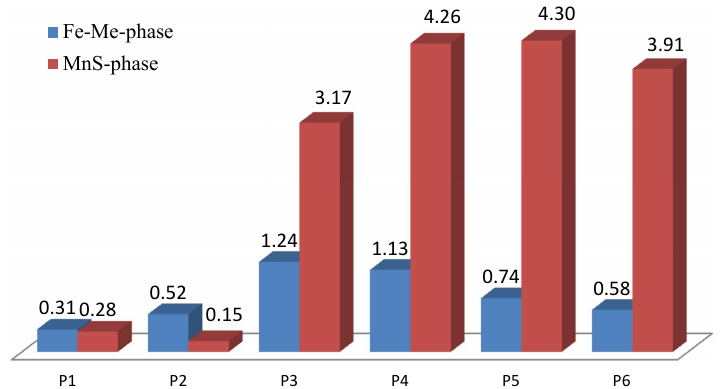
Figure 6. Fractions in % of the two main metal-bearing phases in samples P1–P6, determined with MLA software.